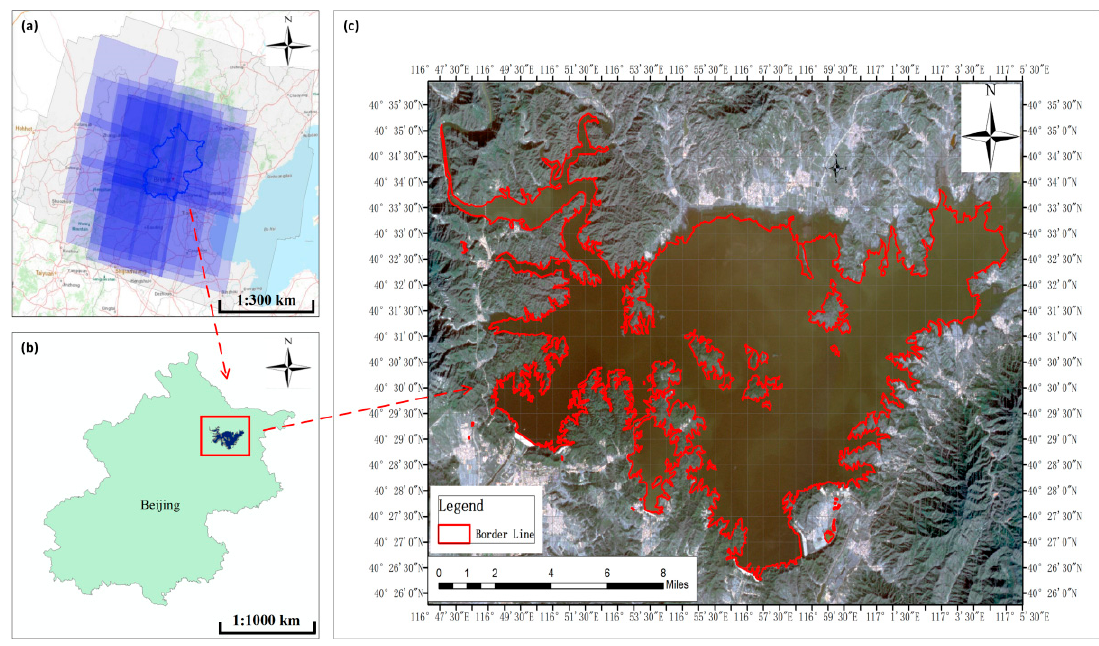
Figure 4. ( a ) Massive GF-1 WFV imageries from April 2013 to April 2022 covering Beijing province; ( b ) the selected study area, the Miyun reservoir, located in Beijing; ( c ) the GF-1 WFV imageries covering the Miyun reservoir (Date: 22 October 2021).